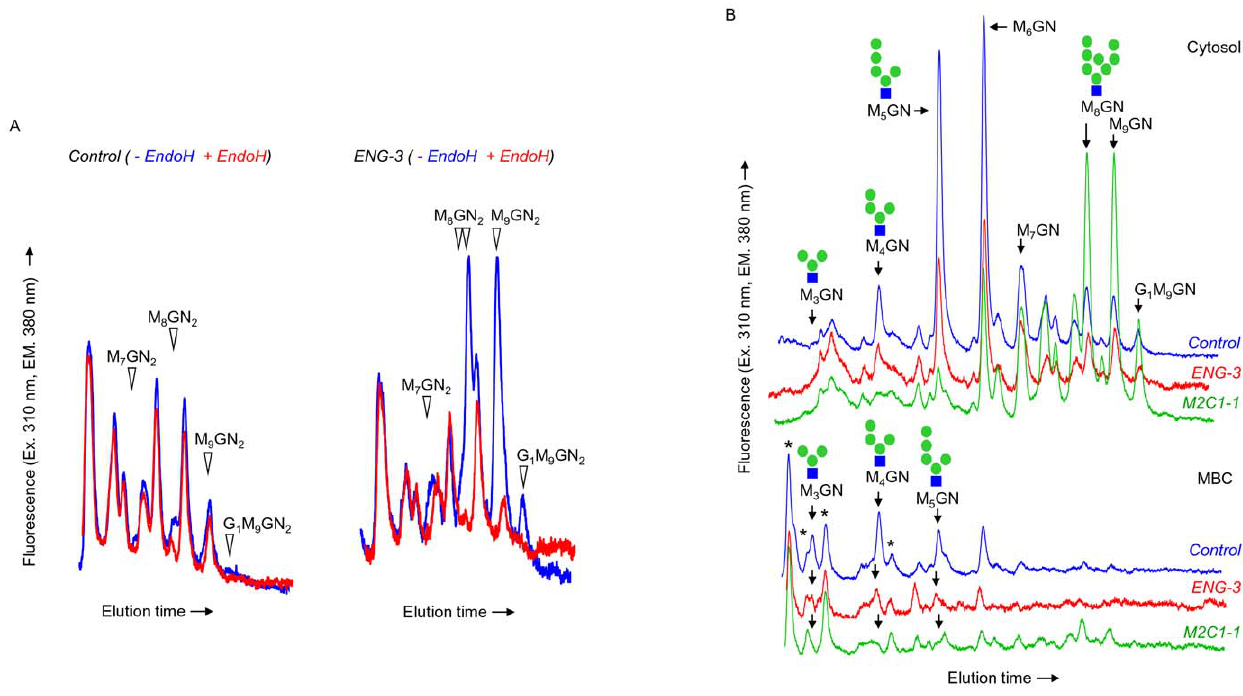
Figure 3. Effects of Engase1p and Man2c1p down regulation on steady-state levels of cytosolic and MBC fOS in HepG2 cells. fOS recovered from both the cytosol and the MBC fractions of SLO-permeabilized, control siRNA ( Control ), ENG-3 or M2C1-1 -transfected cells, were derivatized with 2-AP, and analyzed by HPLC before ( 2 EndoH ) and after digestion with EndoH from S. plicatus ( + EndoH ). A. HPLC profiles of the cytosolic PA-derivatized fOS obtained before (Blue traces) and after EndoH (Red traces) digestion from control siRNA (Left panel) or ENG-3 (Right panel) transfected HepG2 cells. The open arrowheads indicate the migration positions of fOSGN2-AP derivatives whose appearance is abrogated after EndoH digestion. Only the region of the chromatograms that display significant differences before and after EndoH digestion is shown. B. The EndoH treated fOS from the cytosol (Upper panel) and membrane bound compartments MBC (Lower panel) were resolved by HPLC and the migration positions of standard radioactive oligosaccharide 2-AP derivatives are indicated, and where known, the isomeric configuration of the standard structures are indicated (Green circles; mannose, blue squares; N -acetylglucosamine). The asteriks indicate peaks corresponding to oligosaccharides whose abundance does not change under the different conditions. In both A and B the background noise associated with the ENG-3 profiles is higher than in either the control or M2C1-3 traces because the fluorescence scale was amplified to take into account the smaller amount of cells recovered from ENG-3 transfected cultures. This experiment was performed once, but a preliminary experiment, in which cells were not permeabilised with SLO, was performed and found to give qualitatively similar results.